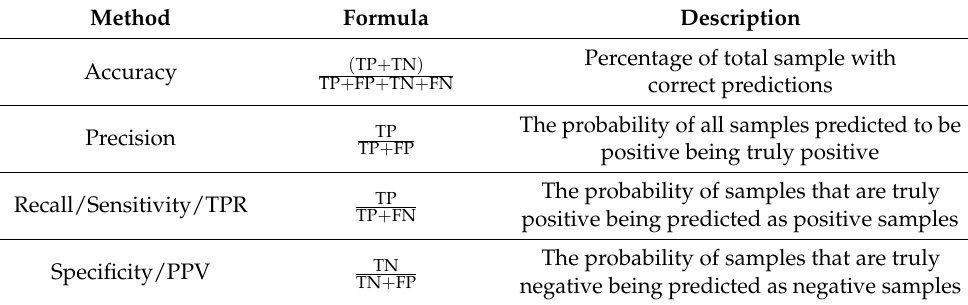
Table 1. The details of evaluation metrics used for NLP